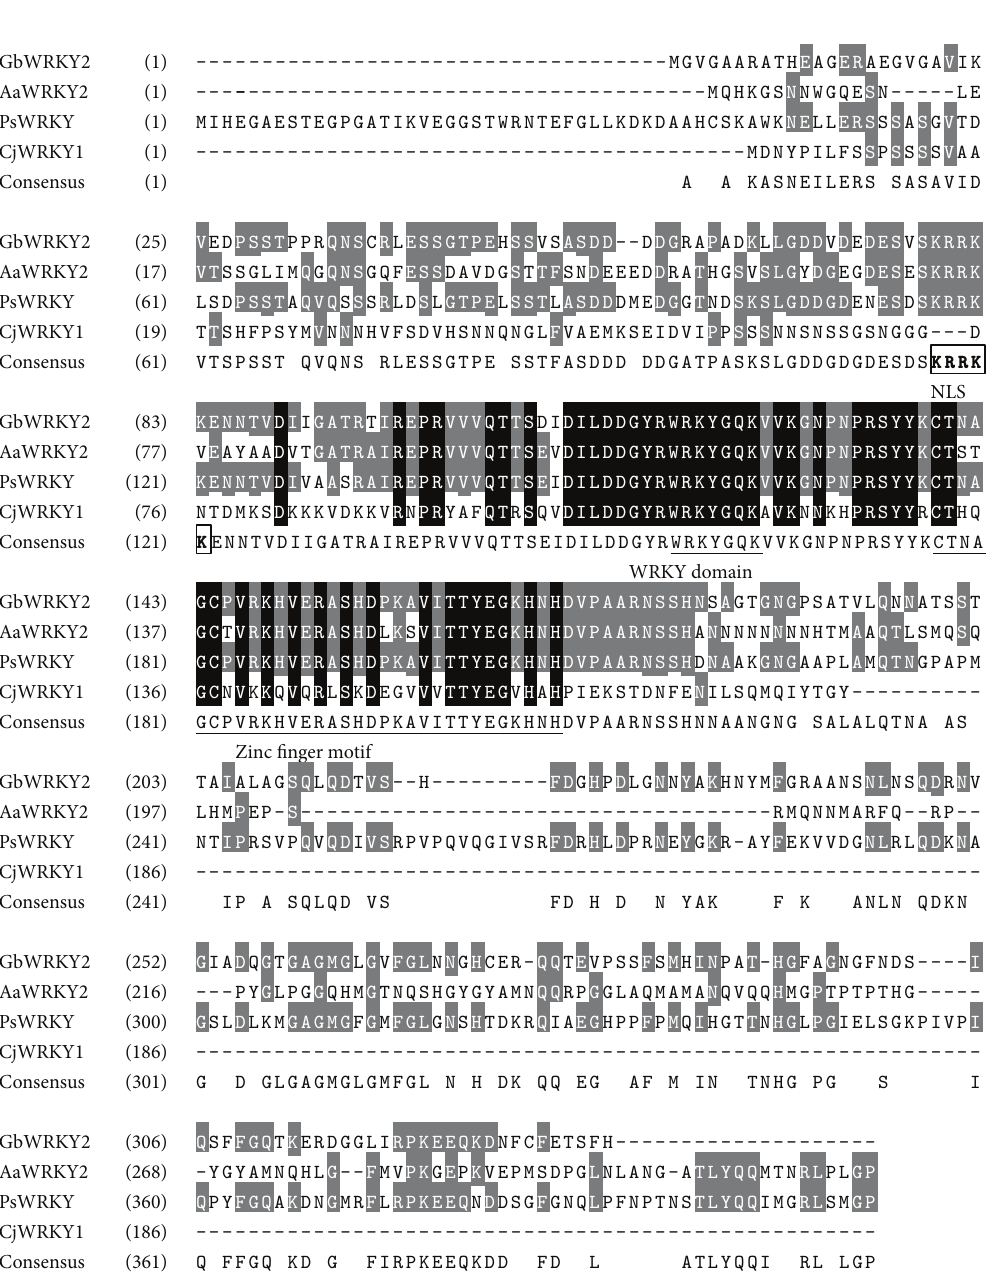
Figure 6: Sequence multialignment of the deduced GbWRKY2 protein with other WRKYs. The completely identical amino acids are indicated with white foreground and black background. The conserved amino acids are indicated with white foreground and grey background. Nonsimilar amino acids are indicated with black foreground and white background. The WRKY domain and zinc finger motif (CX 4 CX 23 HX 1 H) are underlined. A putative nuclear localization signal (KRRKK) is shown by bold letters and boxed. The GenBank accession numbers of WRKY proteins and translation of their names are shown as follows: GbWRKY2: Ginkgo biloba ; CjWRKY1: Coptis japonica var. dissecta BAF41990.1; PsWRKY: Picea sitchensis ADE77055.1; AaWRKY2: Artemisia annua